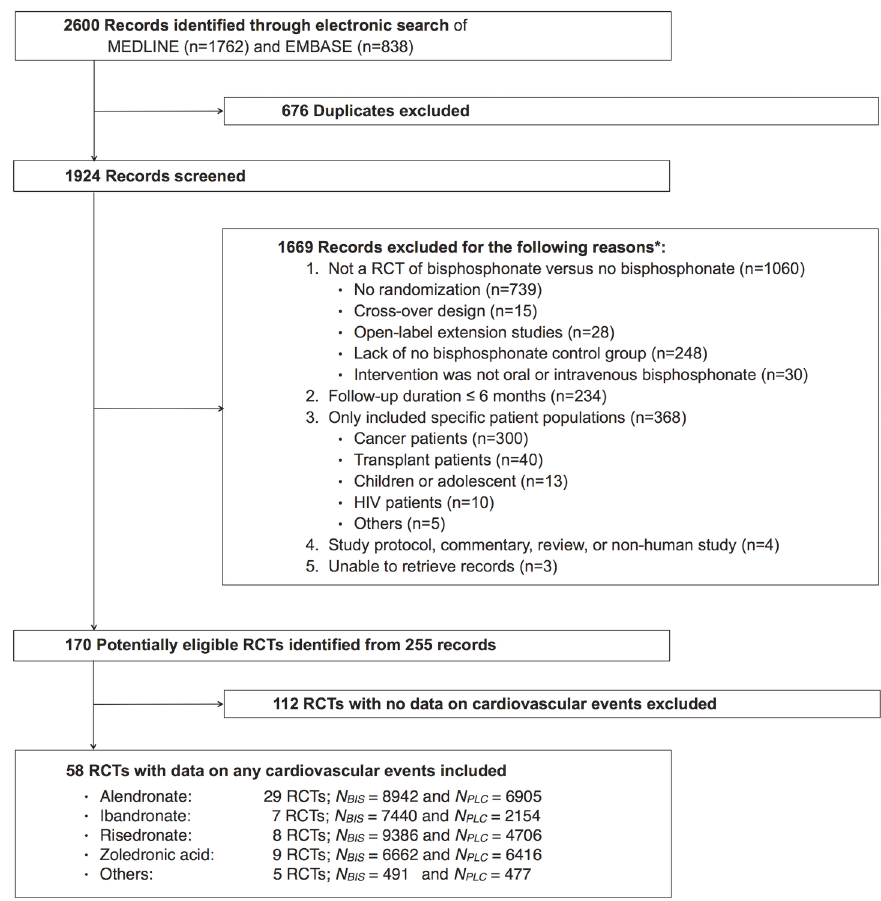
Fig 1. Selection of Randomized Controlled Trials of Bisphosphonates for Meta-Analysis. Abbreviations: BIS, bisphosphonate; CTR, control; HIV, human immunodeficiency virus; RCT, randomized controlled trial